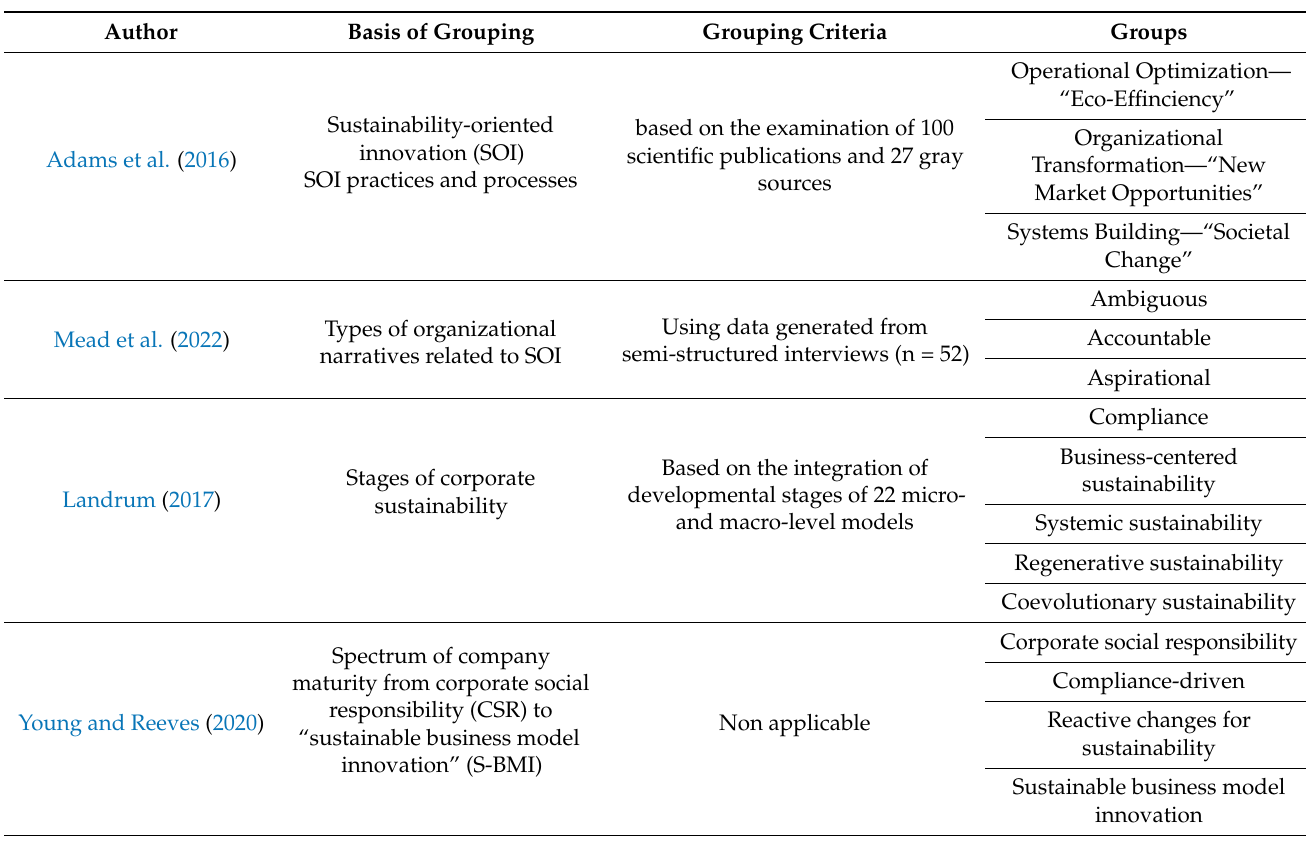
Table 4. Related relevant publications on the sustainability strategies and their classifications. Source: edited by the